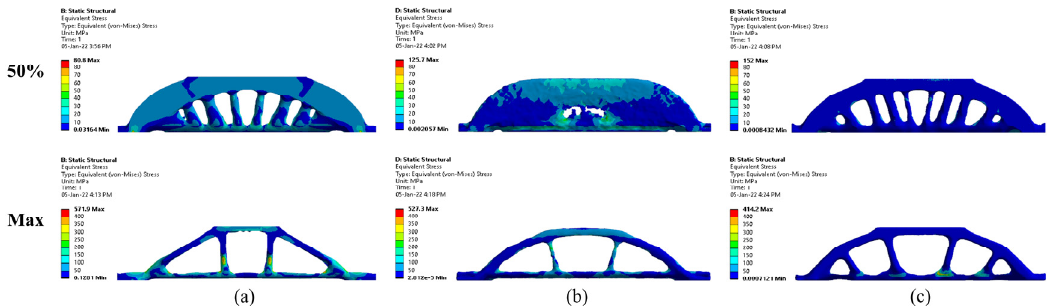
Figure 11. The results of the validation studies for the bridge for 50% and maximum weight reduc- tion in ( a ) SolidWorks, ( b ) ANSYS Mechanical, and ( c ) ABAQUS.